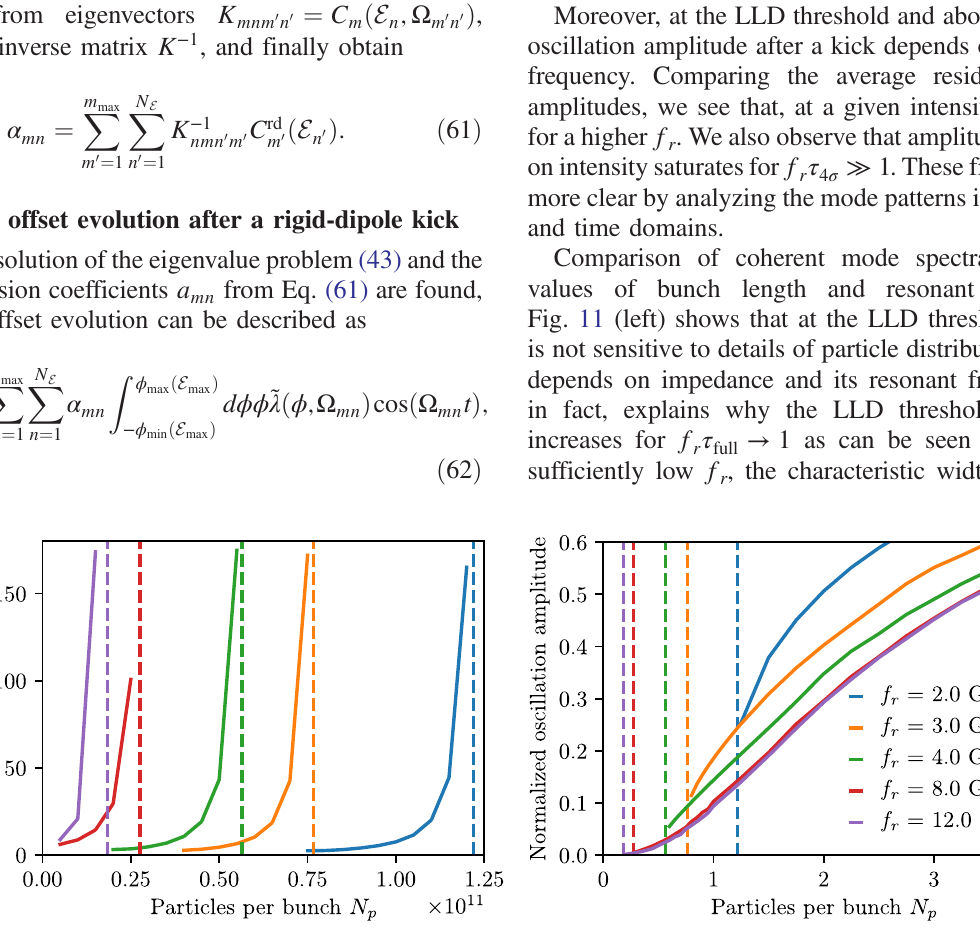
4 GHz and r ¼ ≈ 5 . 7 × 10 10 . th